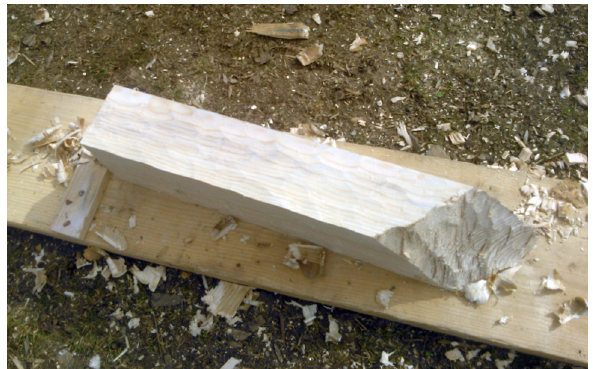
Figure 2. The investigated test tool